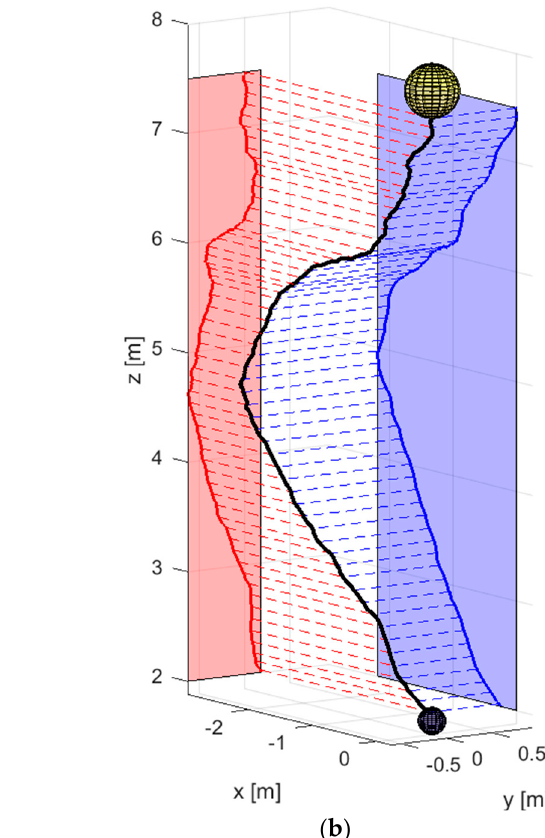
Figure 6. Spark channel reconstruction: ( a ) photographs and trajectories; ( b ) reconstructed spark channel.